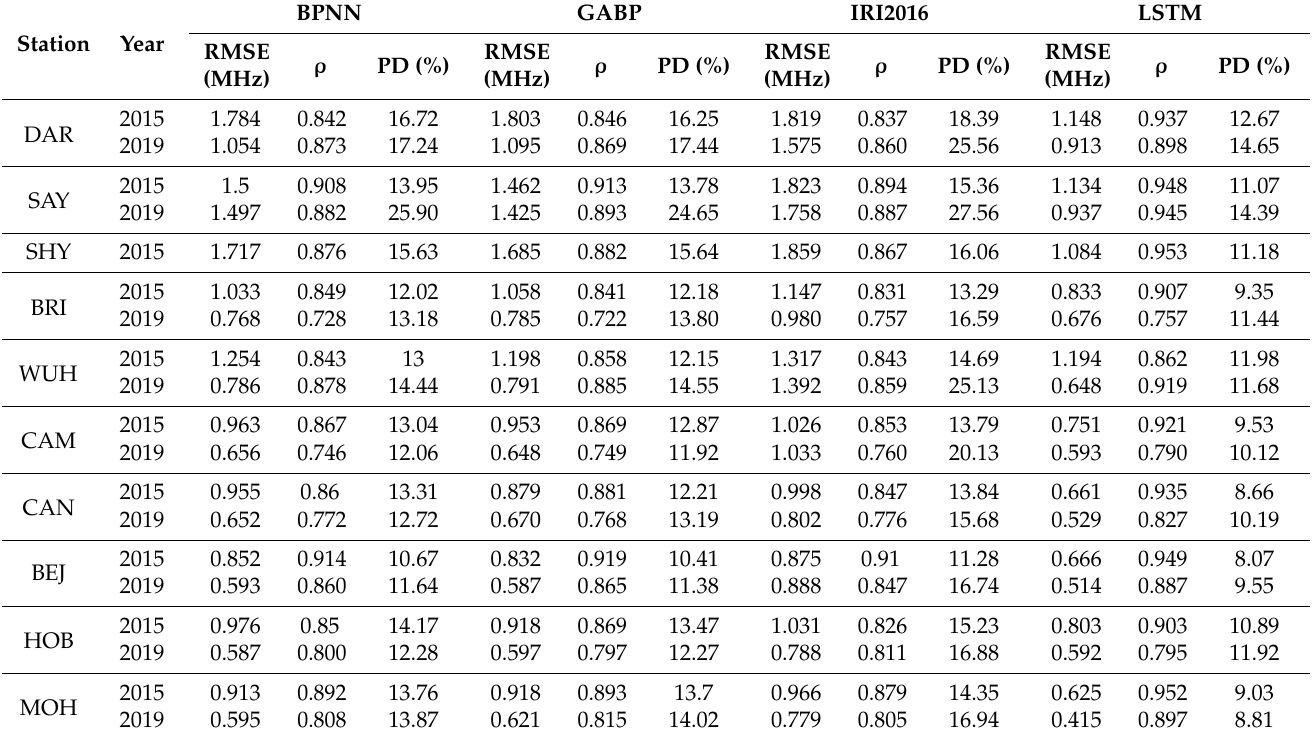
Table 3. The prediction errors of foF2 between the observed and forecasting values derived from the 4 models during the year of solar maximum (2015) and solar minimum